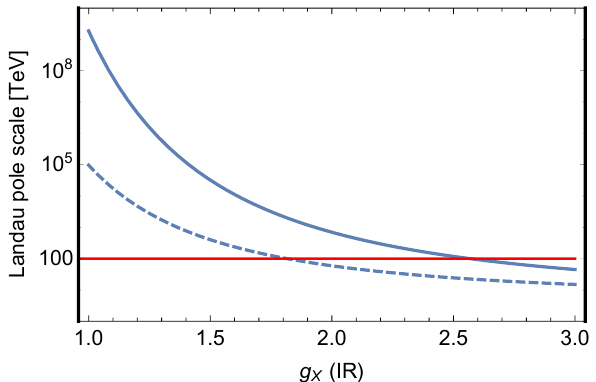
Figure 10 . Location of the one-loop Landau pole for the U(1) gauge groups associated with the SU(4) symmetric quartics (solid line) and the gauge group associated with the SU(8) symmetric quartic (dashed line). Here we assume only the supermultiplets containing Higgs-like (cid:12)elds are charged under the new groups, and the IR scale is taken to be (cid:24) 5TeV. Further UV completion